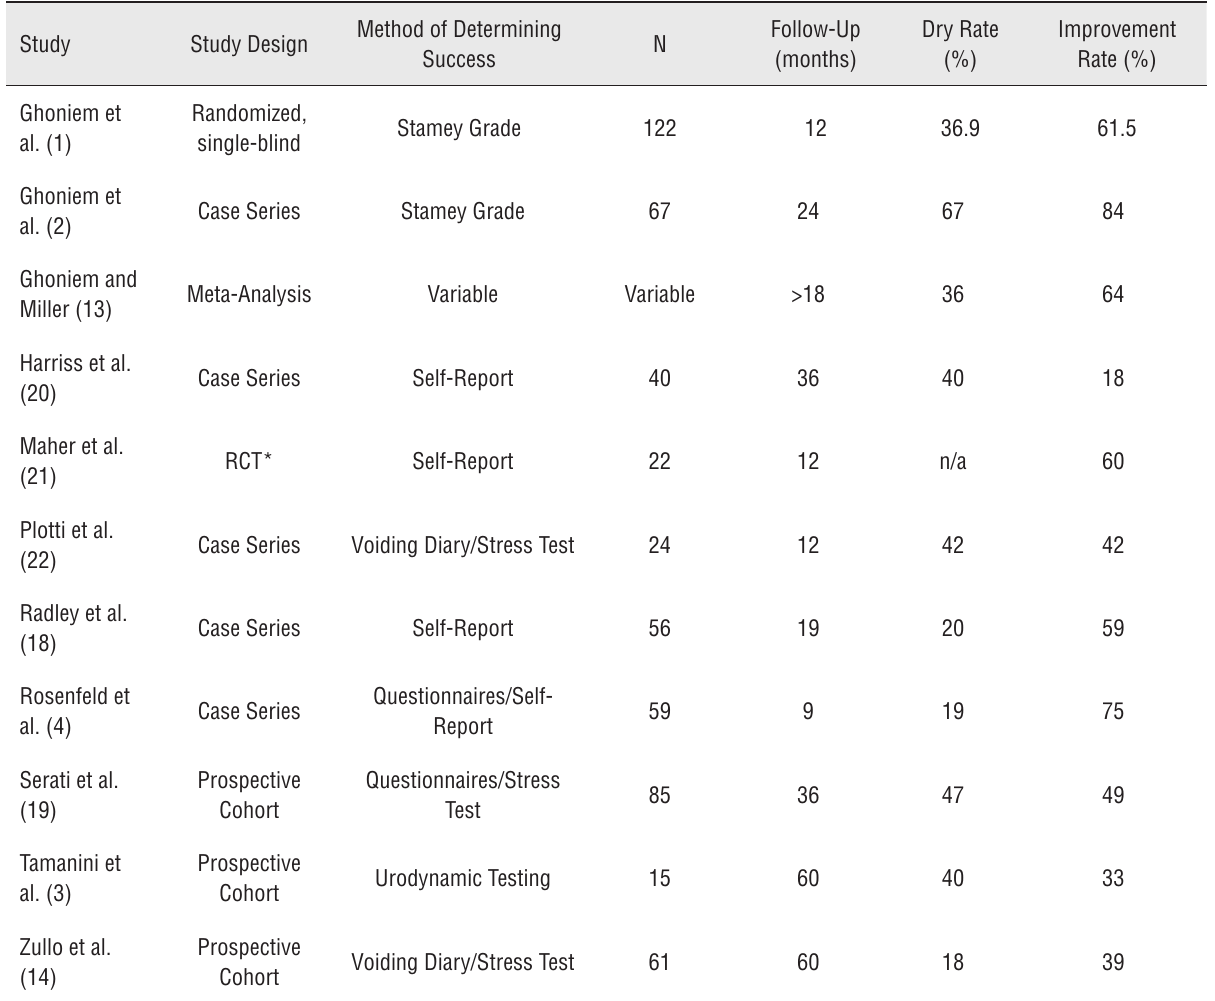
Table 4 - Success Rates in the